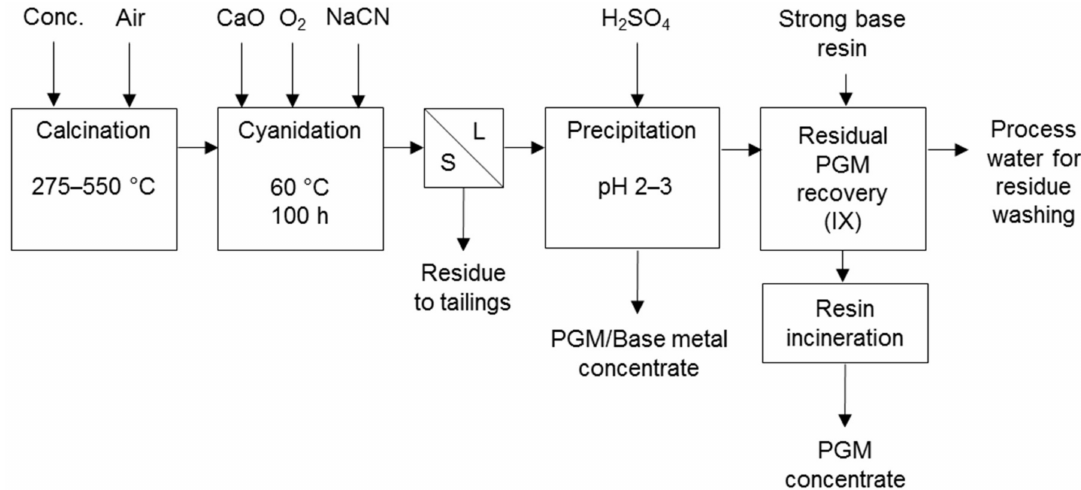
Figure 11. Panton process flow sheet (adapted from Lewins & Greenaway